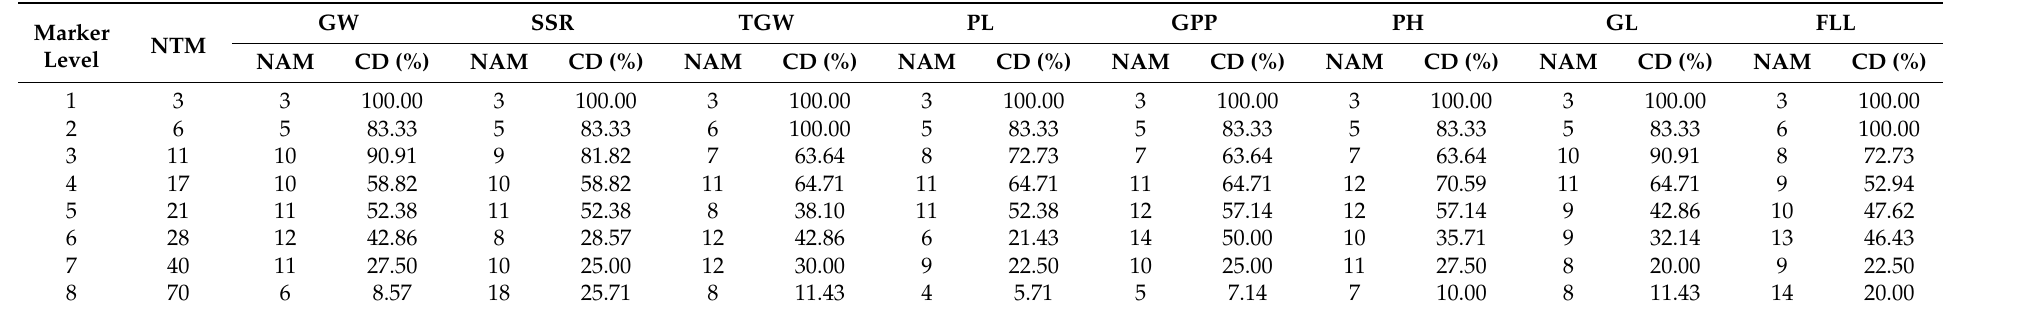
Table 4. Correlation between different grade markers and agronomic